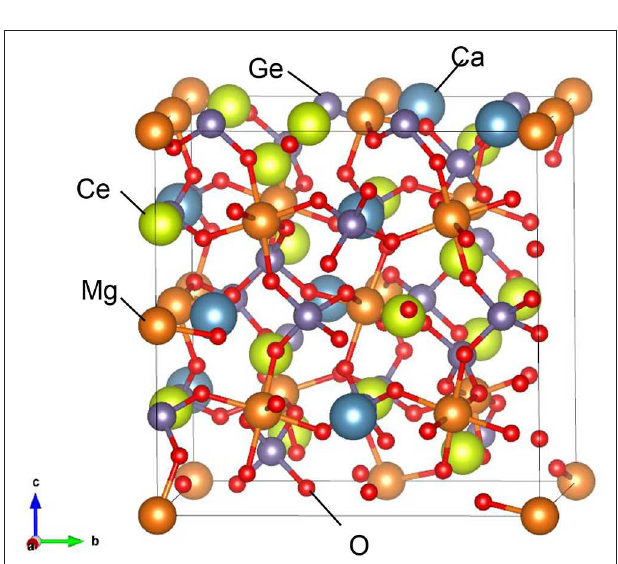
FIGURE 4 | (A) UV–vis absorption spectrum, and (B) photoluminescence emission ( λ ex = 519nm) and excitation ( λ em = 600nm) spectra for Ce 2 CaMg 2 Ge 3 O 12 , collected at room temperature.